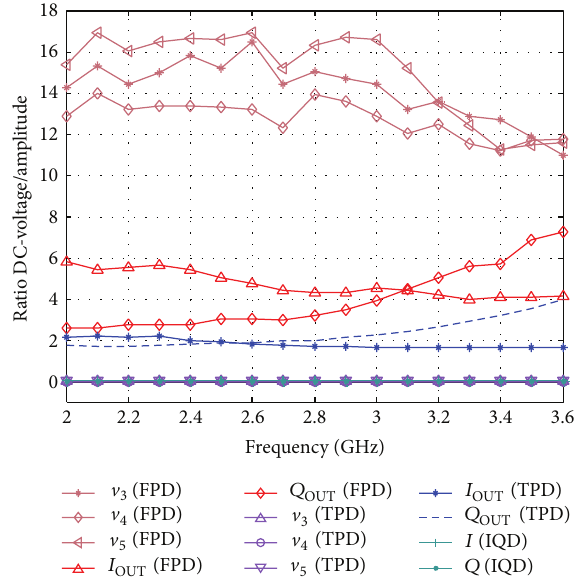
(𝑡) and 𝑄 (𝑡) signals at the Figure 6: Measured amplitudes of 𝐼 OUT OUT output of the 𝐼/𝑄 regeneration circuit connected to FPD and TPD = 5 dBm, 𝑃 = −25 dBm, and Δ𝑓 = 10 kHz). and for IQD ( 𝑃 LO RF